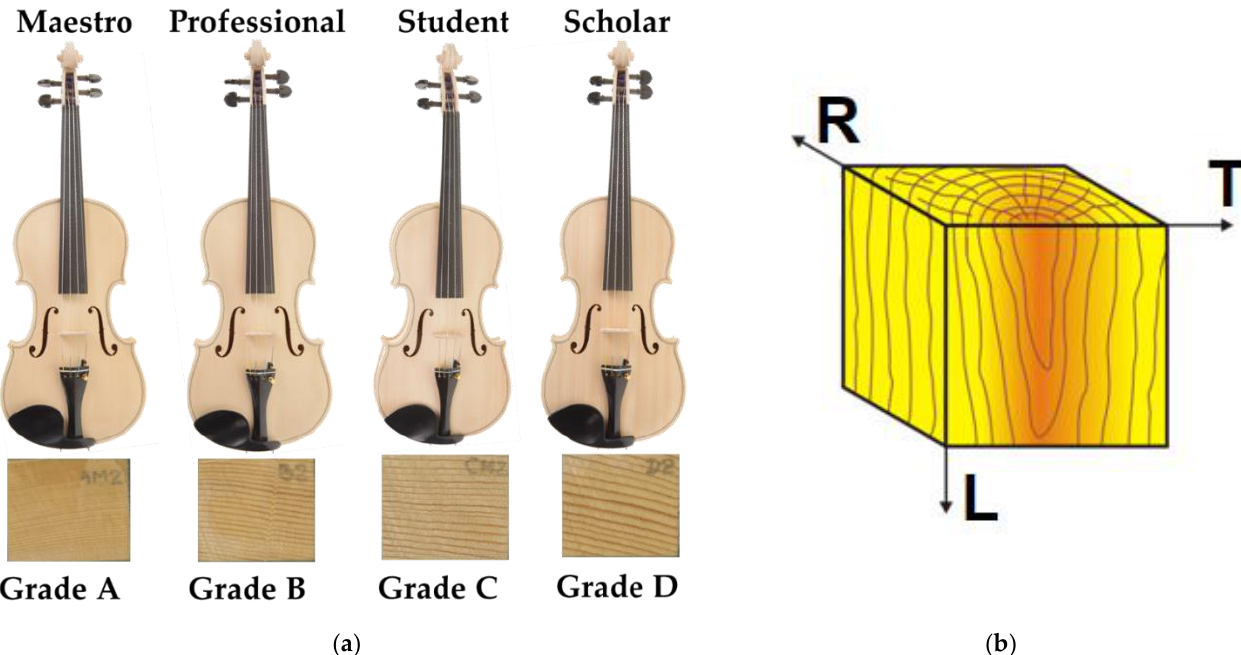
Figure 1. Types of samples analyzed: ( a ) correspondence between the quality class of the wood depending on the anatomical characteristics and the quality classes of the violins; ( b ) the main sections of wood (L: longitudinal; R: radial; T: tangential). Table 1. The physical features of the spruce wood samples.